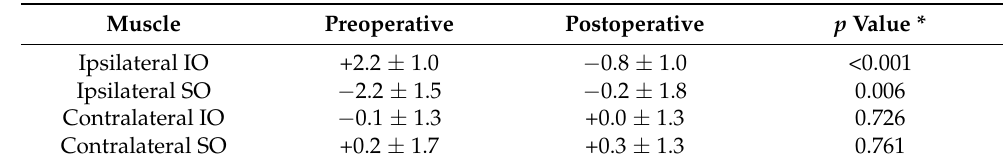
Table 1. Demographics of patients.